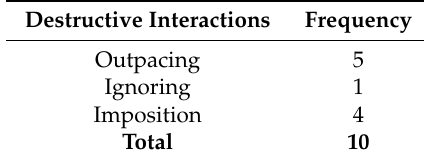
Table 3. Frequencies of destructive